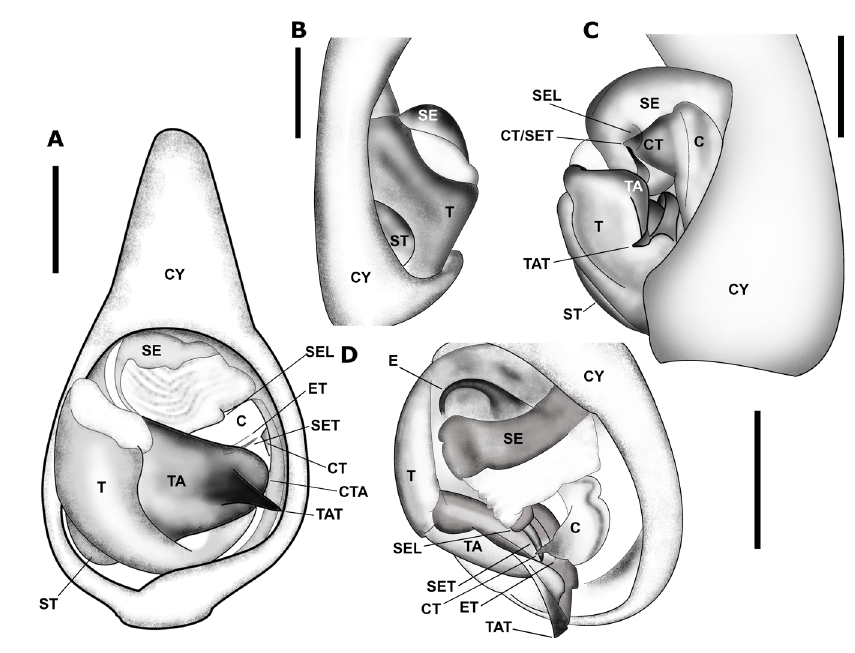
Fig. 19. Lycosa hyraculus sp. nov., holotype, ♂ (HUJ INV-AR20818), left pedipalp line drawings. A . Ventral view. B . Prolateral view. C . Retrolateral view. D . Distal view. Scale bars = 0.5 mm. Drawings by I. Armiach